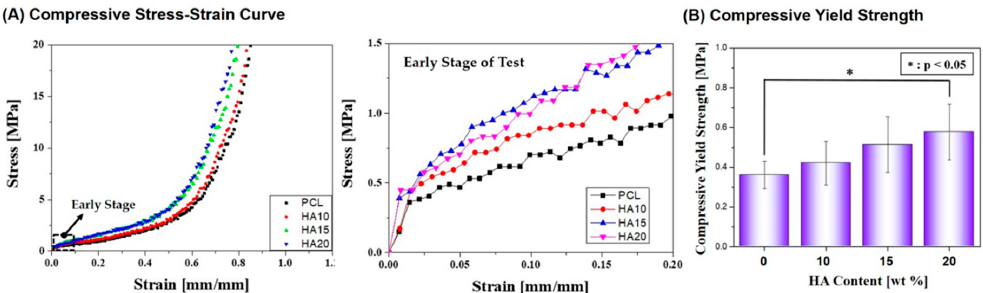
Figure 6. ( A ) Ultimate tensile strength and ( B ) elastic modulus of the macro/micro-porous PCL/HA composite scaffolds (HA content = 0 wt %, 10 wt %, 15 wt %, and 20 wt %).